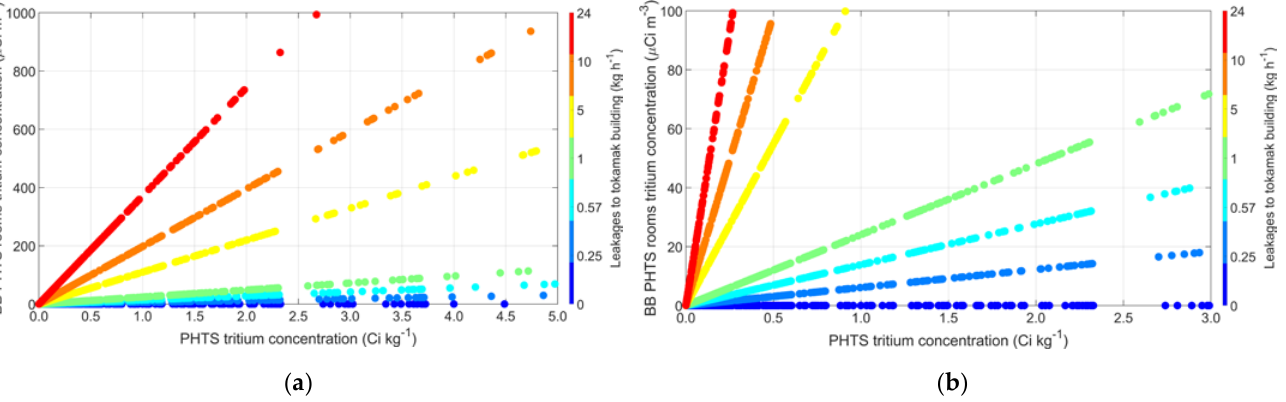
Figure 1. Tritium concentration in BB PHTS rooms for different leak rates as function of tritium concentration in primary coolant: ( a ) full range between 0 and 1000 µCi m −3 ; ( b ) detail for small tritium concentration values.